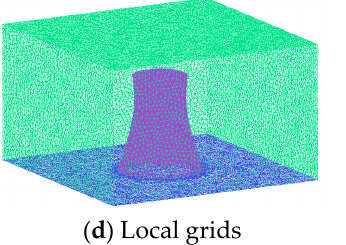
Figure 1. Computational domain and grid generation for the super large cooling tower.